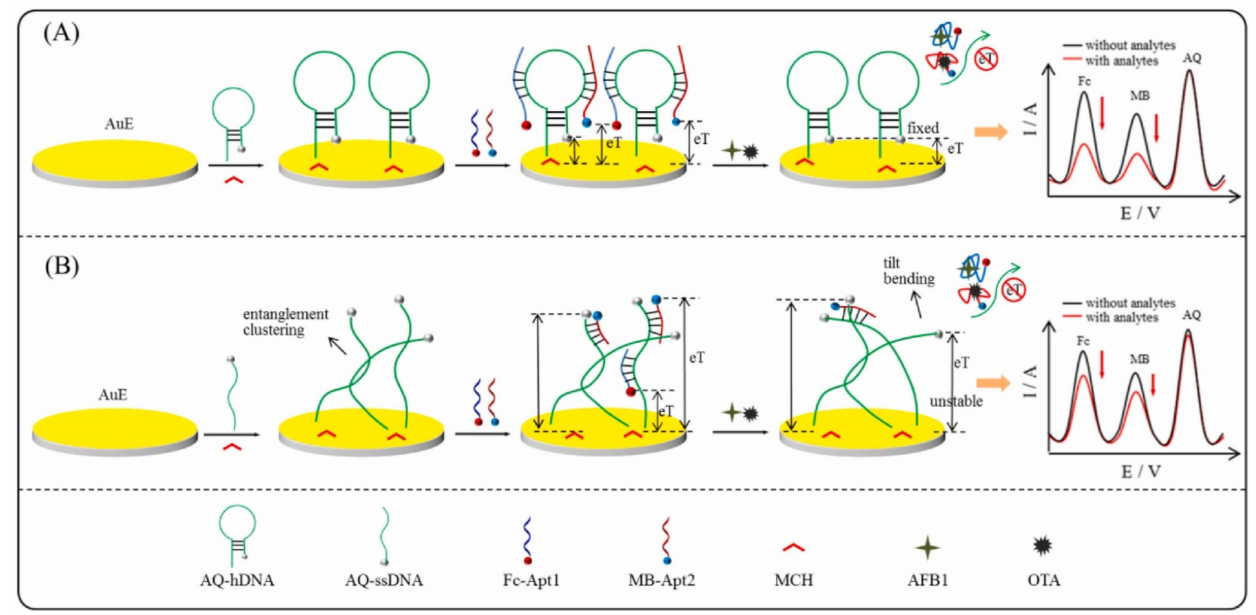
Figure 3. Schematic illustration of simultaneous determination of AFB1 and OTA using ( A ) the hDNA-based and ( B ) ssDNA-based dual-ratiometric electrochemical aptasensor (reprinted with permission from Zhu et al.